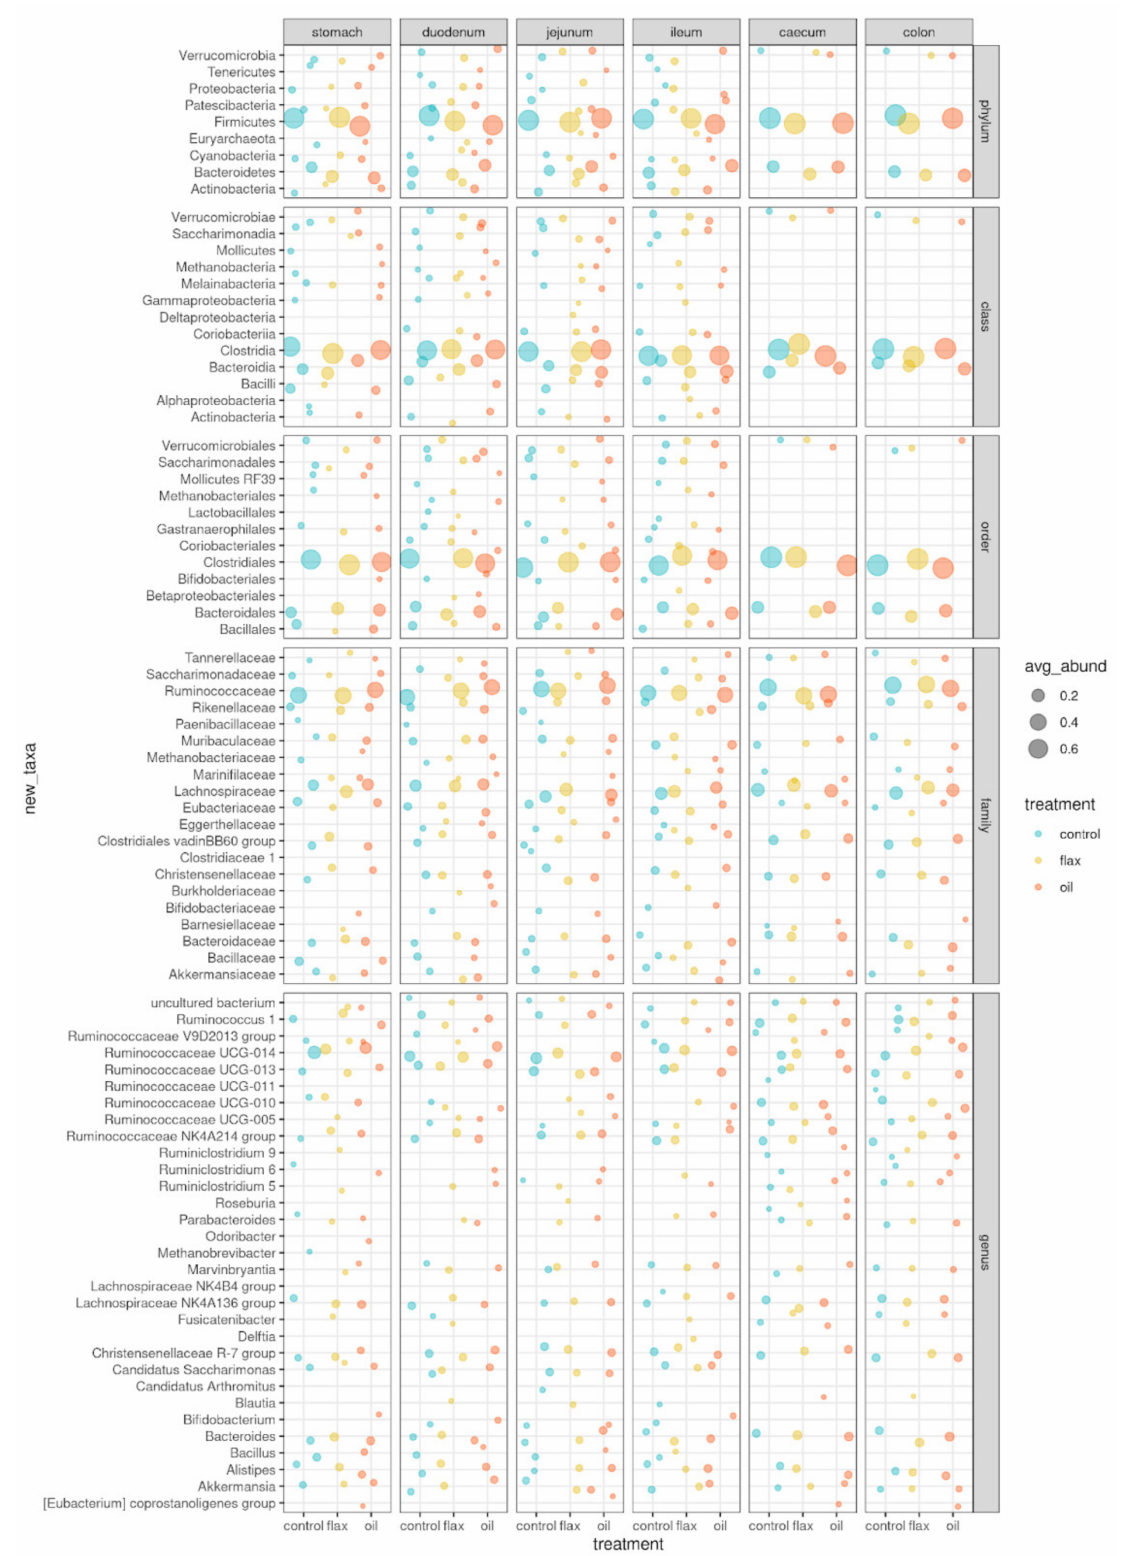
Figure 2. Bubble chart of relative abundances of all taxa ( ≥ 1%) in the gut microbiota of the three groups of rabbits, grouped by taxonomic level (from phylum to genus). Control (blue = 5 rabbits), flaxseed (yellow = 5 rabbits) and fish oil (red = 5 rabbits) experimental groups. The size of the bubble is proportional to the relative abundance, with 0.2, 0.4, and 0.6 hallmarks, as shown in the